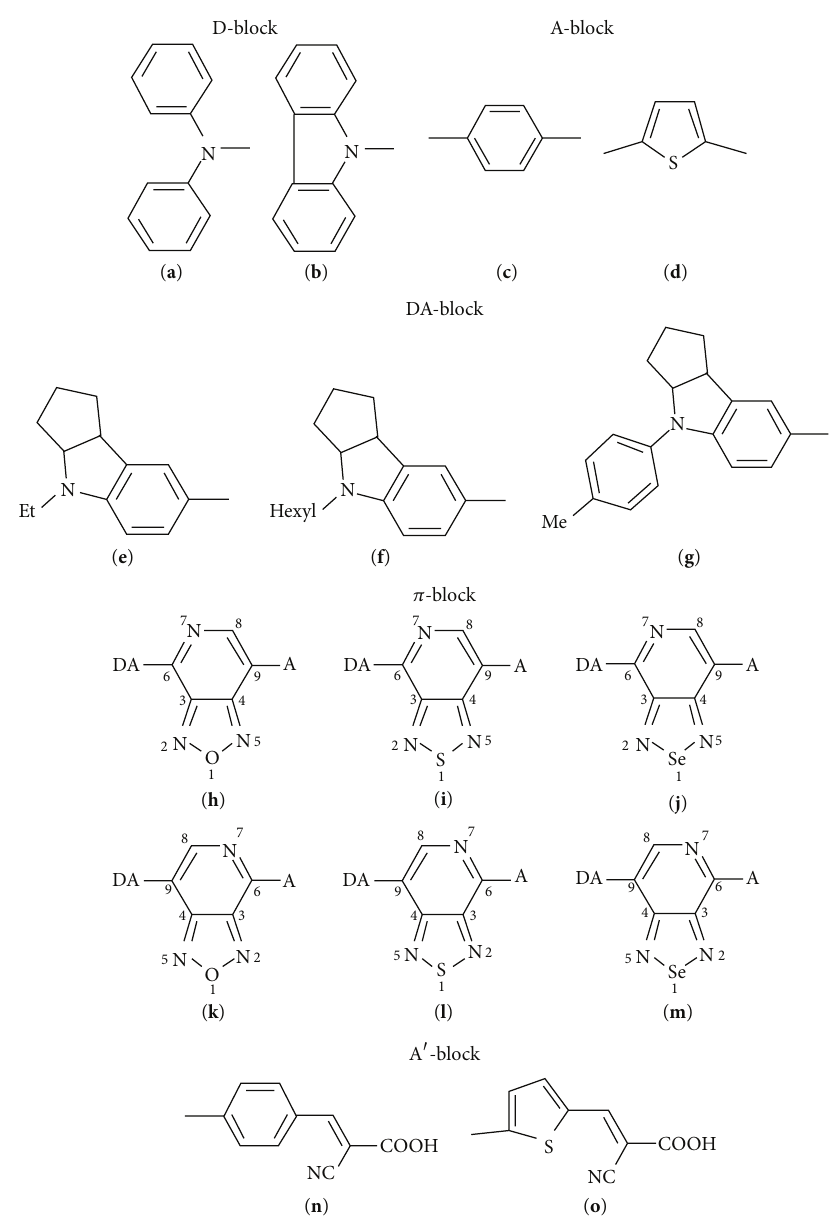
Scheme 1: Building blocks for the design of featured organic